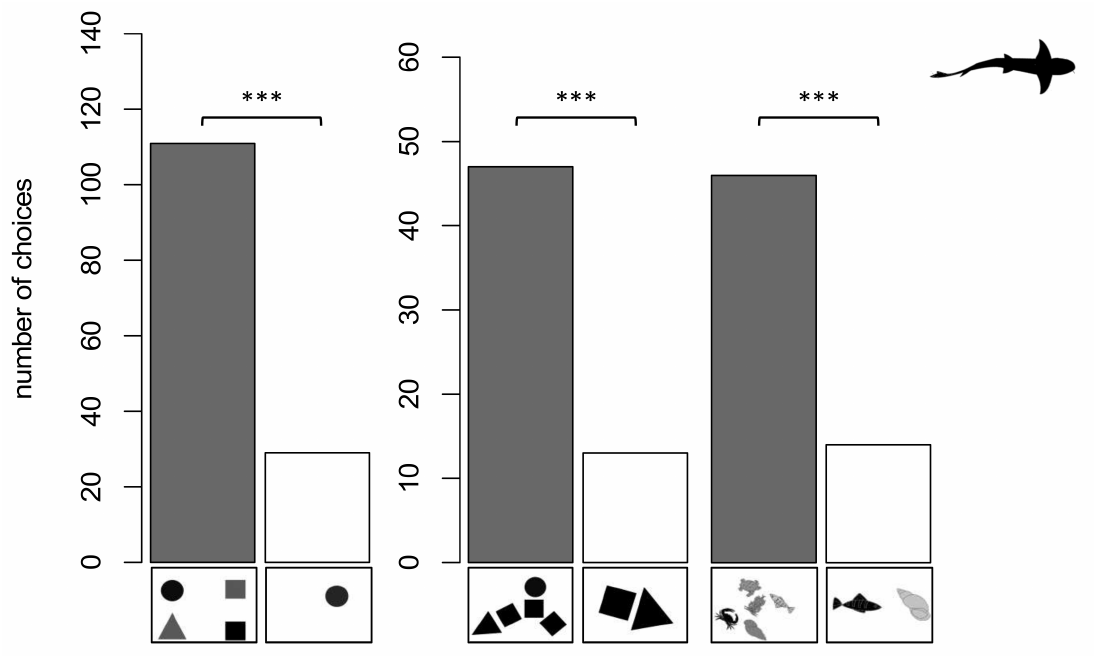
Figure 5. Exemplary graph of the performance of a shark during the entire training and testing phase. The black line shows the percentage of correct choices per ten-trial session. The horizontal red dotted line indicates the lower limit of the LC, while the vertical red line indicates when the LC was achieved. In the sessions following the red vertical line, transfer tests were added to the regular ten trial session. The blue line gives the average trial time for each